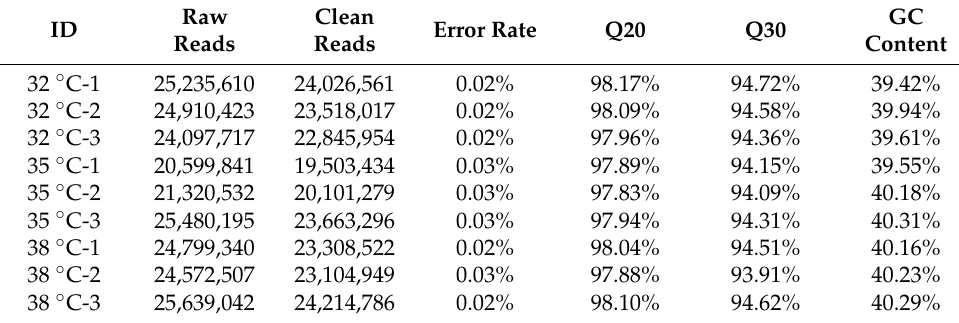
Table 2. Quality control result of sequencing data of P. quatuordecimpunctata under different tempera- ture stress.